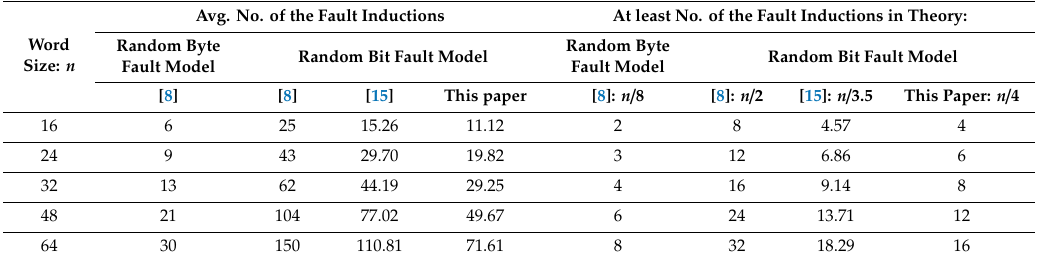
Table 8. Experiment results for the average number of the fault inductions to retrieve K T − 1 / L T − 2 .